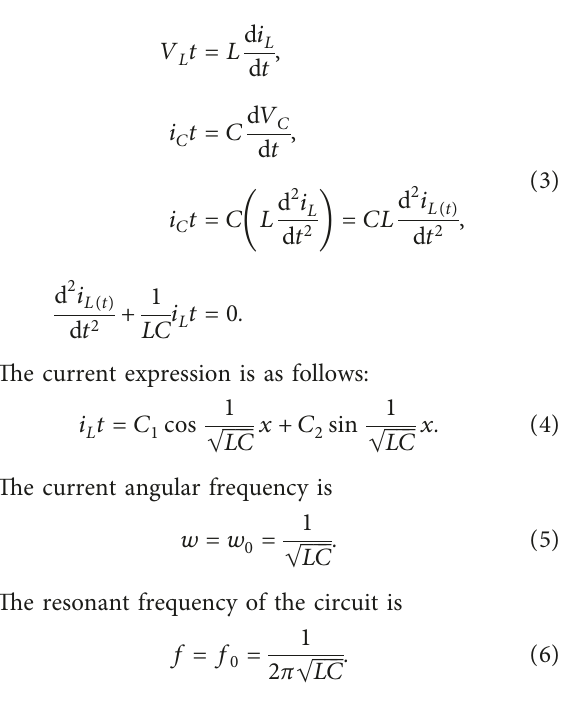
Figure 1: LC resonant circuit model